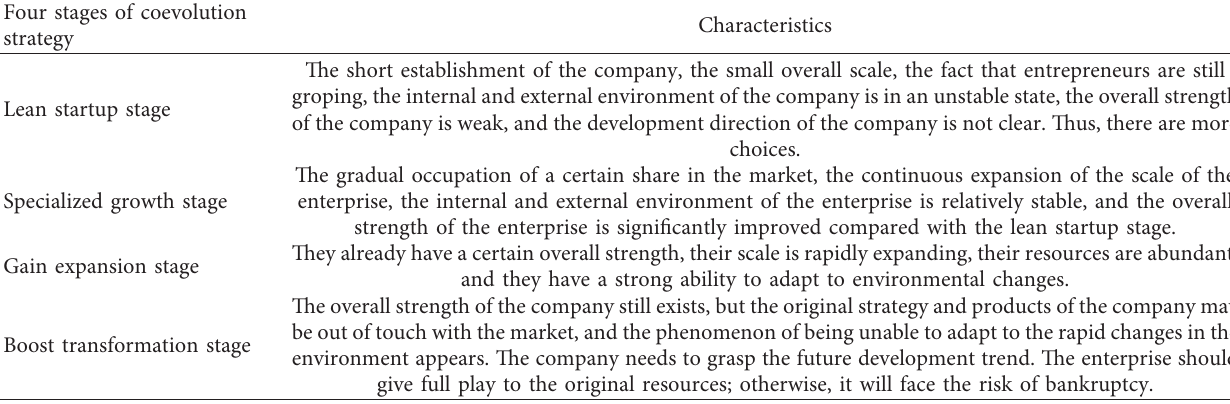
Table 1: Four stage characteristics of coevolution